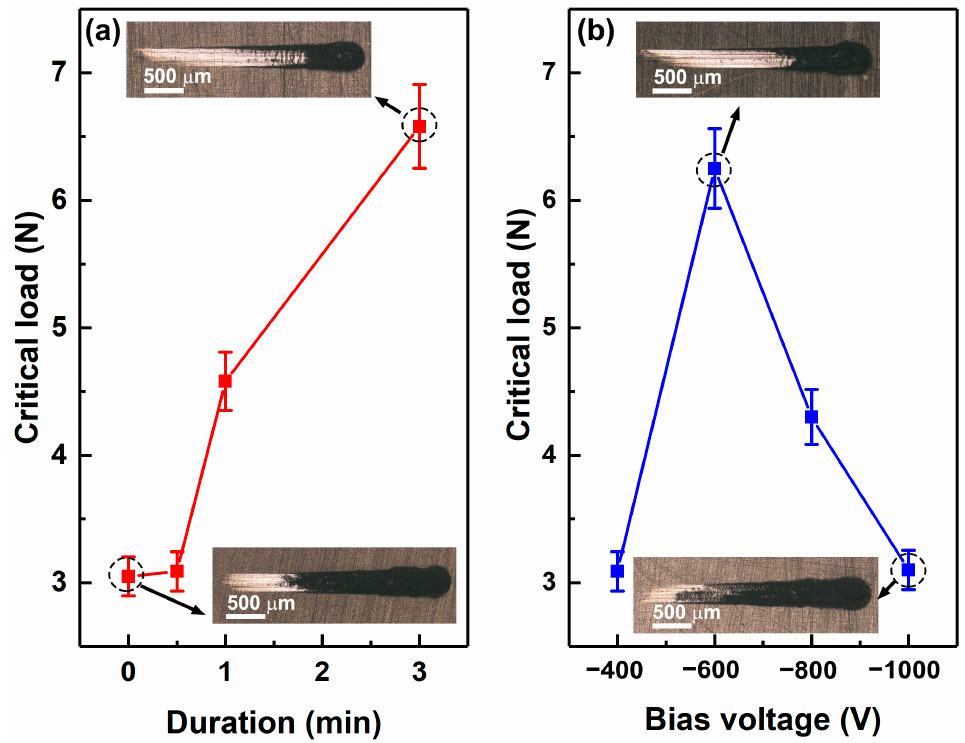
Figure 7. Critical loads of the Cu coatings deposited on the raw ABS and the ABS treated by Cr ions with different durations ( a ) and bias voltages ( b ).